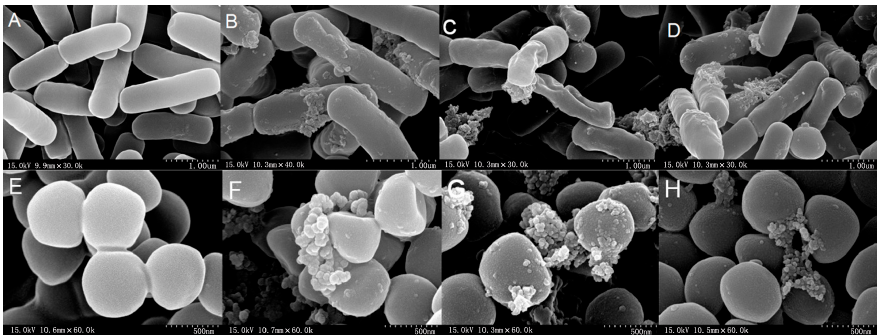
Figure 6. Scanning electron microscopy (SEM) micrographs of E. coli ATCC 25922 and S. aureus ATCC 29213 cells treated with peptides at their 1× MICs at about 1 h. E. coli ATCC 25922: ( A ) Control; ( B ) FV-LL; ( C ) FV-MA; ( D ) FV-CE. S. aureus ATCC 29213; ( E ) Control; ( F ) FV-LL; ( G ) FV-MA; ( H ) FV-CE. The control did not contain the peptides.